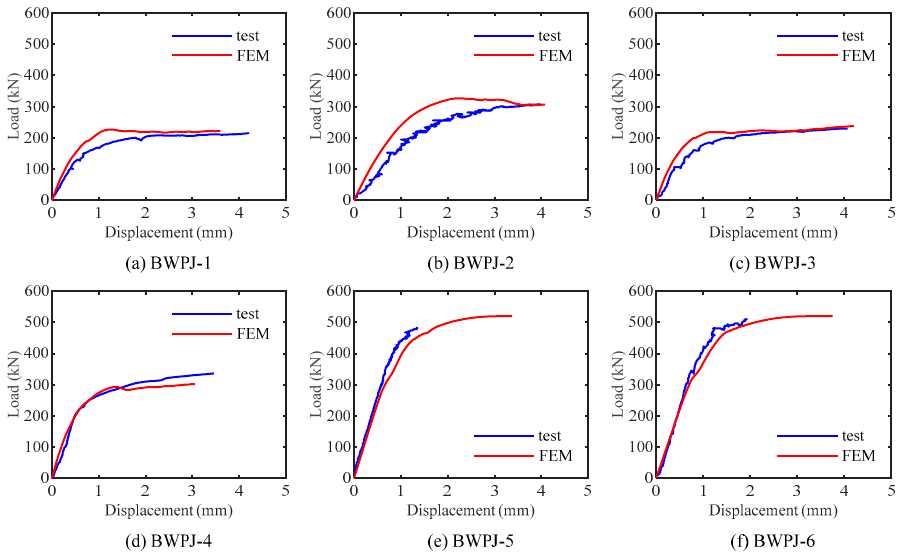
Figure 9. Load-displacement curves. Figure 9. Load ‐ displacement curves. Table 2. Comparison of pulling resistant capacity of test specimens. Table 2. Comparison of pulling resistant capacity of test specimens. Specimen